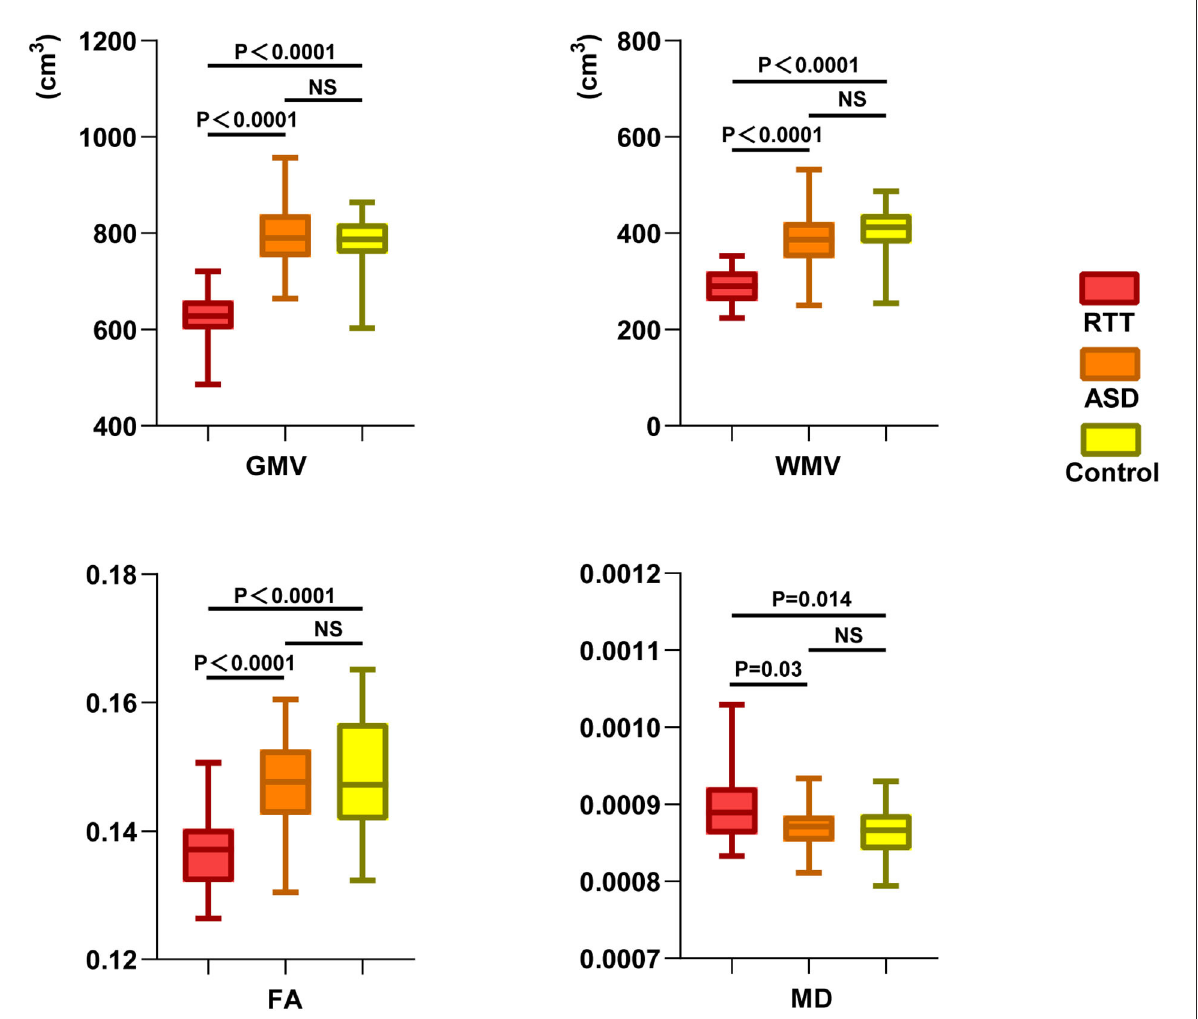
FIGURE2 Global-leveled ANCOVA analysis showed a significant difference in gray and white matter parameters among the three groups. RTT group exhibited significantly decreased GMV, WMV, FA, and increased MD values compared to ASD and TD controls. GMV, gray matter volume; WMV, white matter volume; FA, fractional anisotropy; MD, mean diffusivity; NS, not